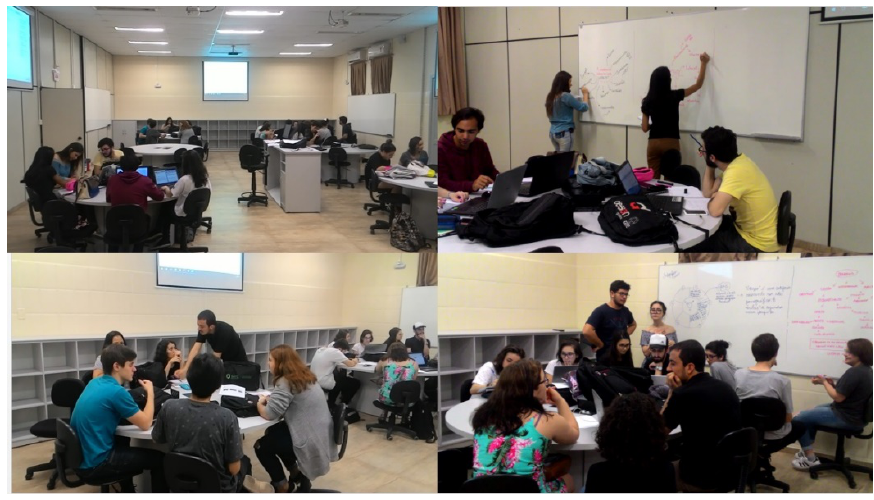
Fig. 4. SATC Active Learning